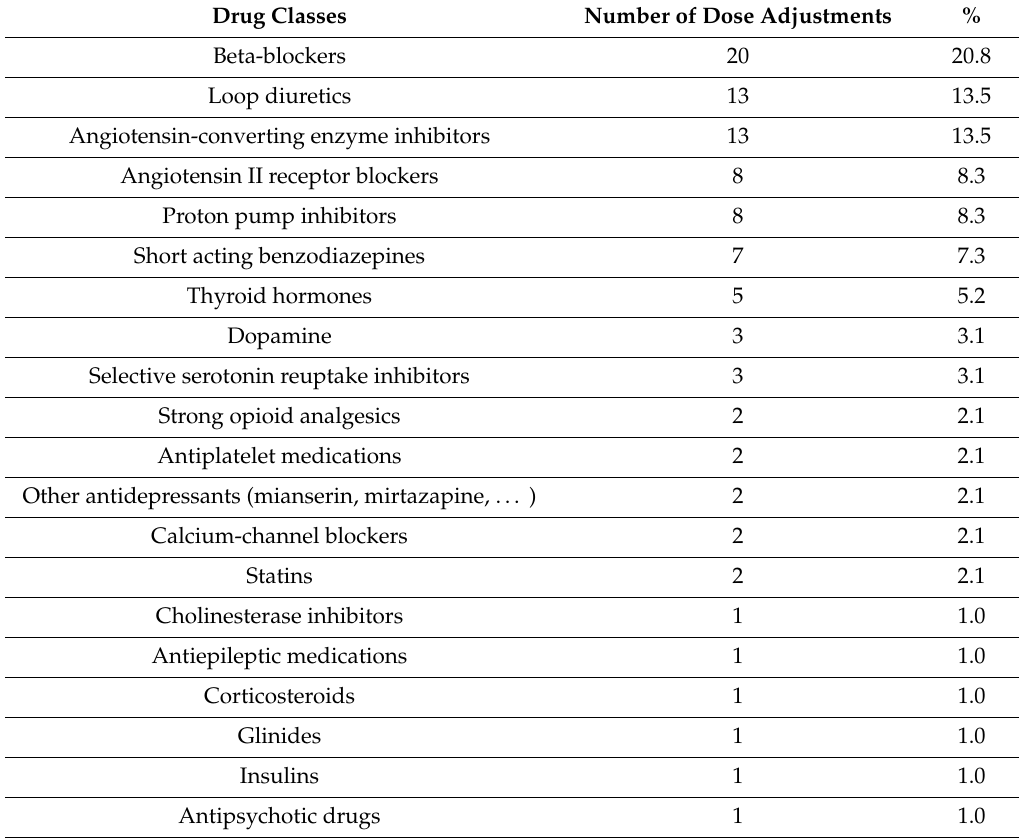
Table 3. Dosage modifications of drugs during the